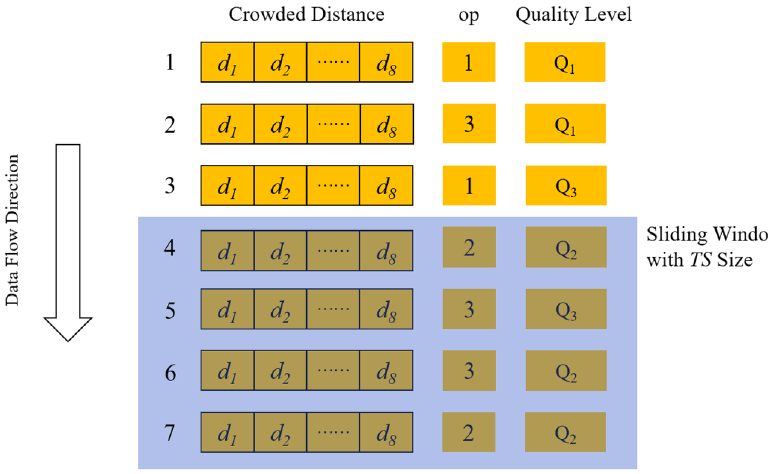
Fig. 4 Illustration of the data structure of evolutionary information and the FIFO sliding